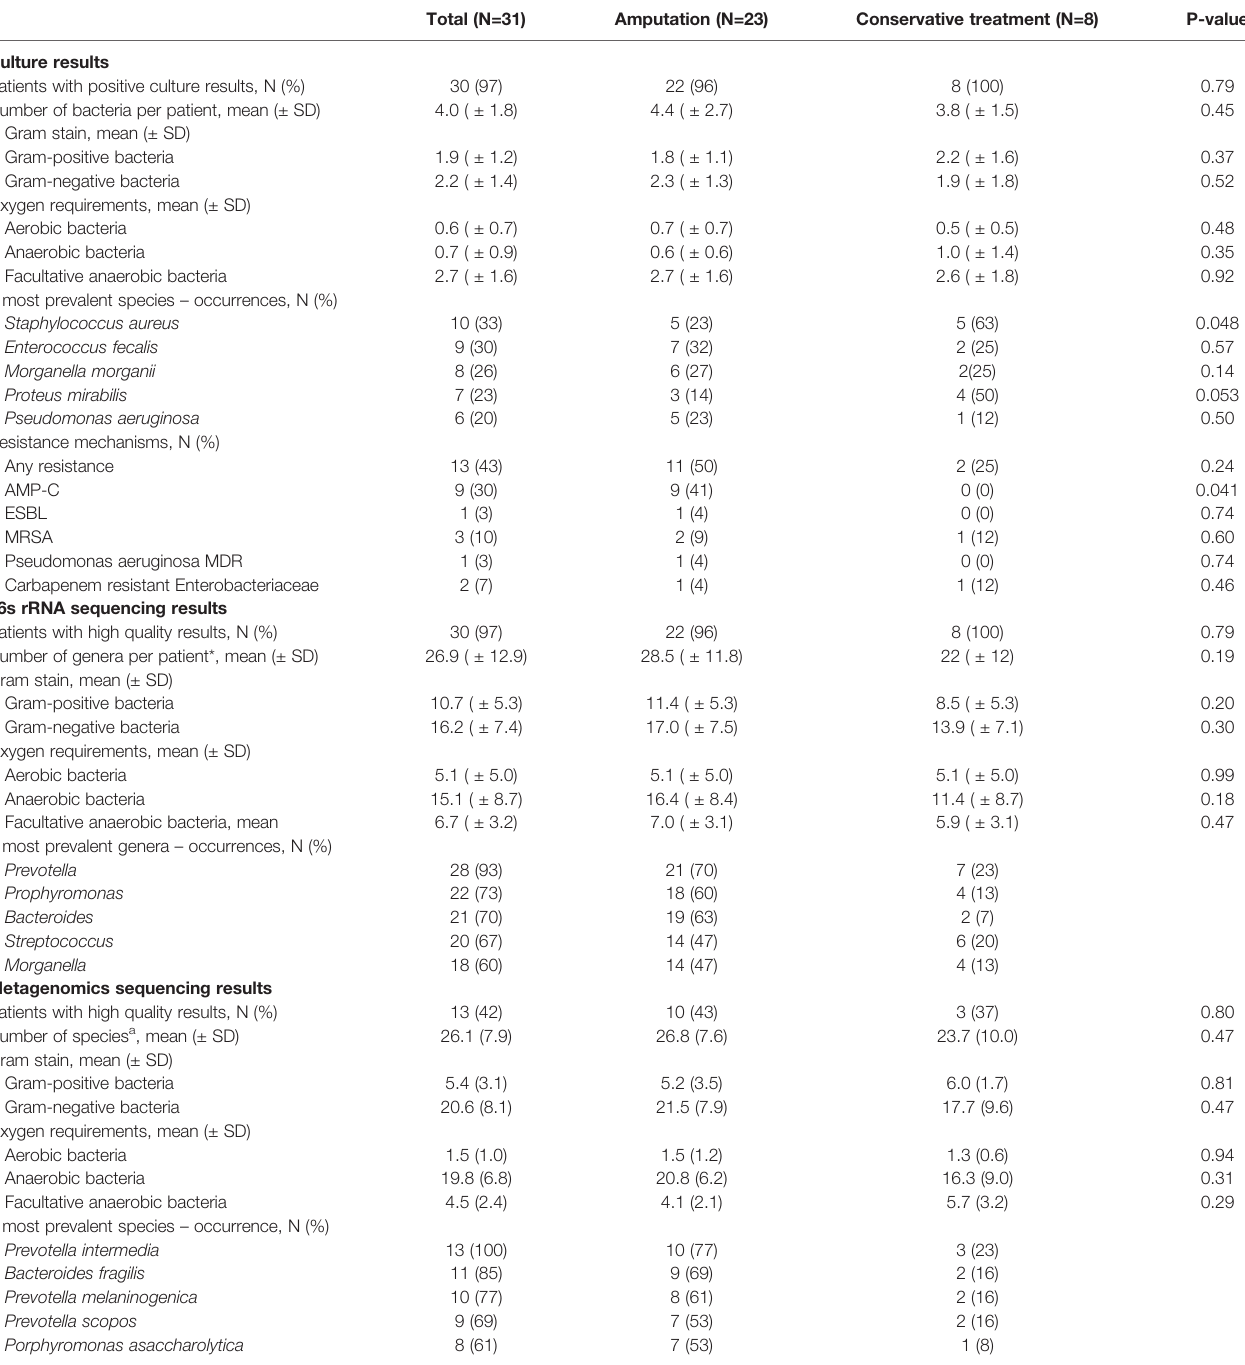
TABLE 2 | Overview of traditional cultures, 16S rRNA sequencing and metagenomic sequencing